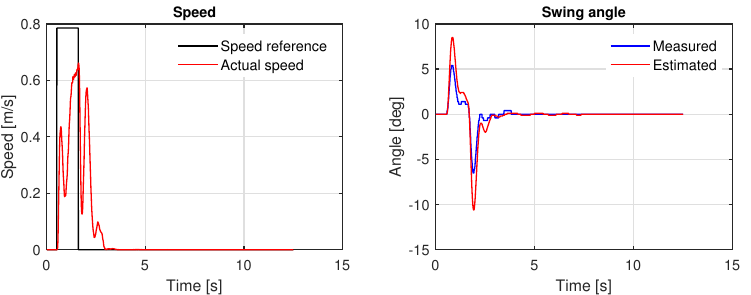
Figure 12. Speed reference and the actual speed and the measured and estimated swing angles when the swing angle feedback control using the estimated angle is applied.